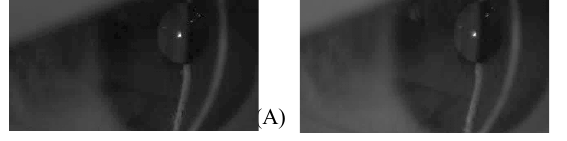
Fig. 2. Image captured with the tomography system of the subject’s eye unaccommodated (A) and accommodated (B).